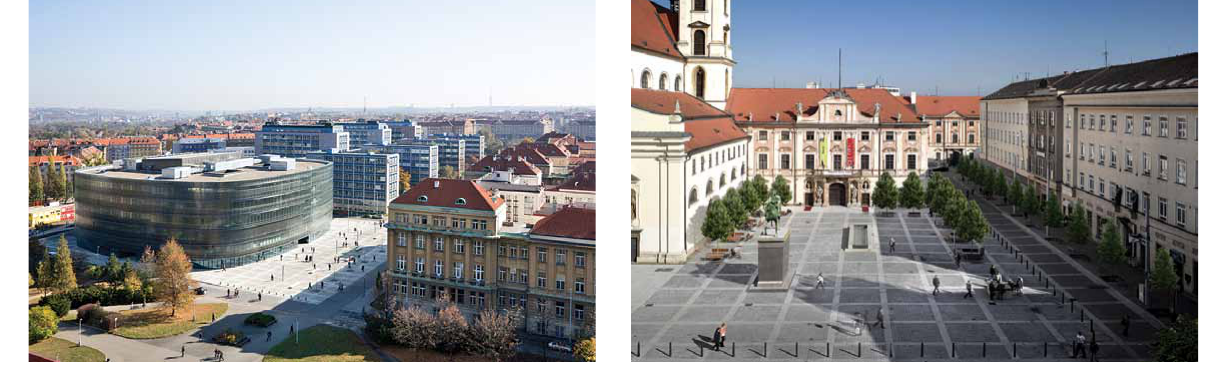
fig. 4. Projektil: national Technical library, 2009. fig. 5. Petr Hrůša: Moravian Square, Brno, 2008.